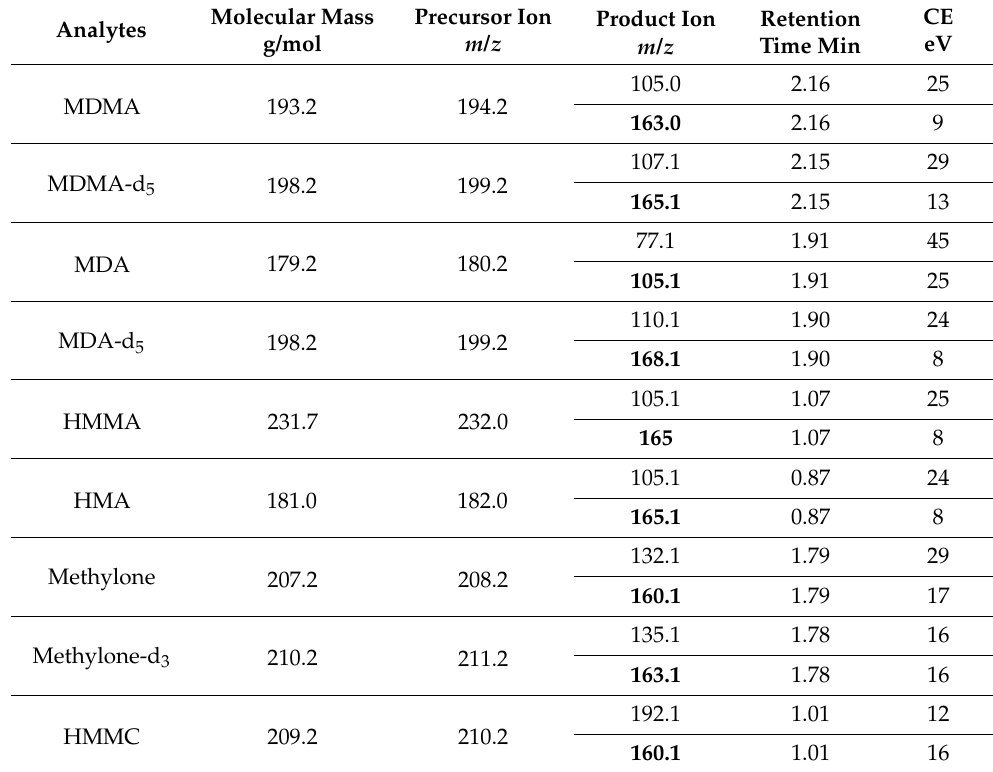
Table 3. Mass spectrometry parameters for analytes and internal standards with positive ionization.